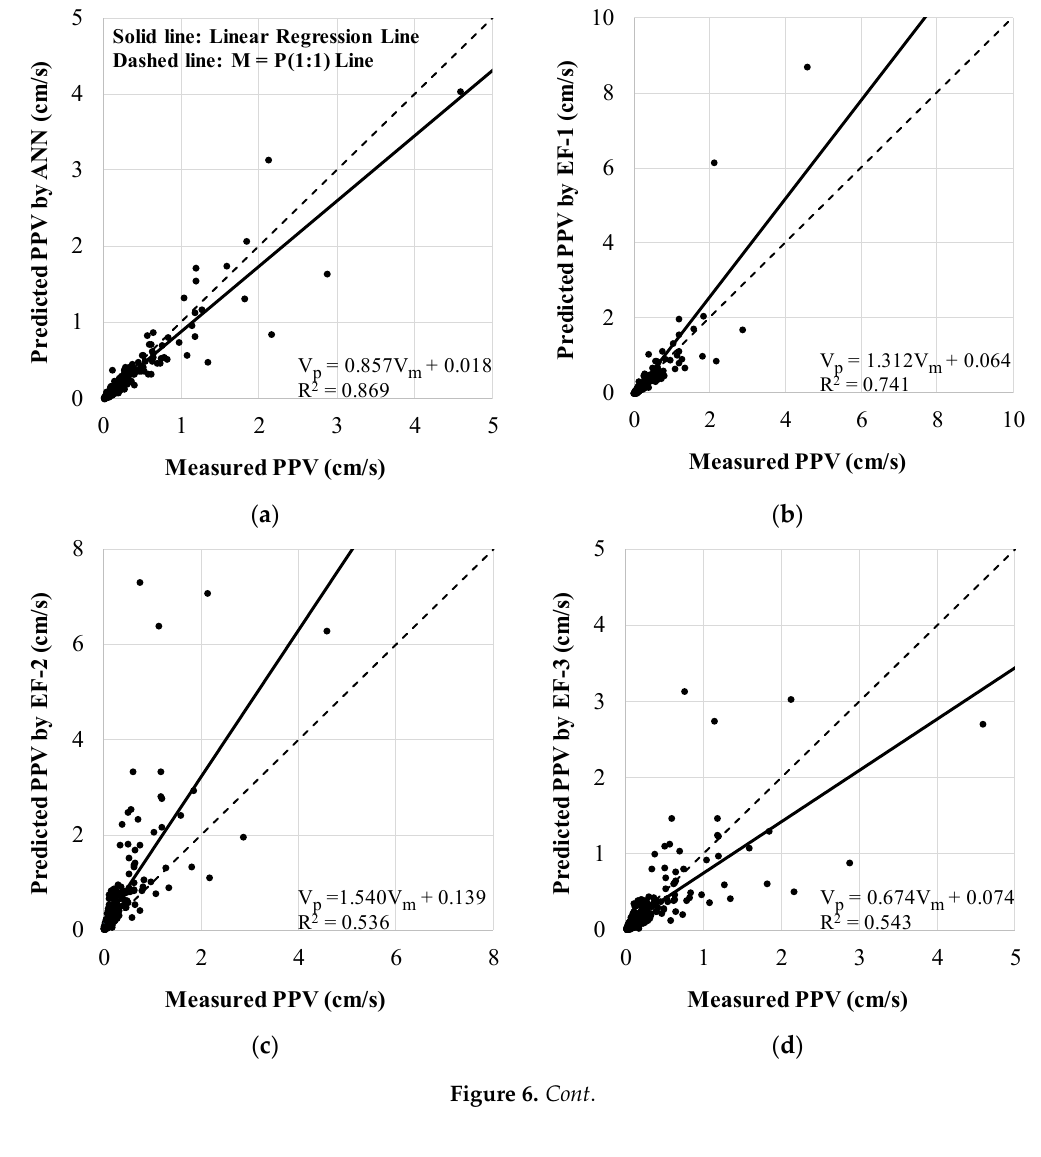
Each predicted PPV by the six prediction methods is plotted as a small circle in Figure 6a to 6h respectively according to prediction methods. The x and y axes represent the measured and predicted PPV, respectively, in cm/s. There are two lines in each figure. The dashed line is the Measured PPV = Predicted PPV (1:1) line and the solid line is the linear regression line. In the lower right corner of each figure, it shows the equation of the linear regression line and R 2 . The linear regression line resulting from the ANN shows the best result in terms of similarity to the 1:1 line as shown in Figure 6. The linear regression line resulting from the MLRA displays the greatest distance between the two lines.